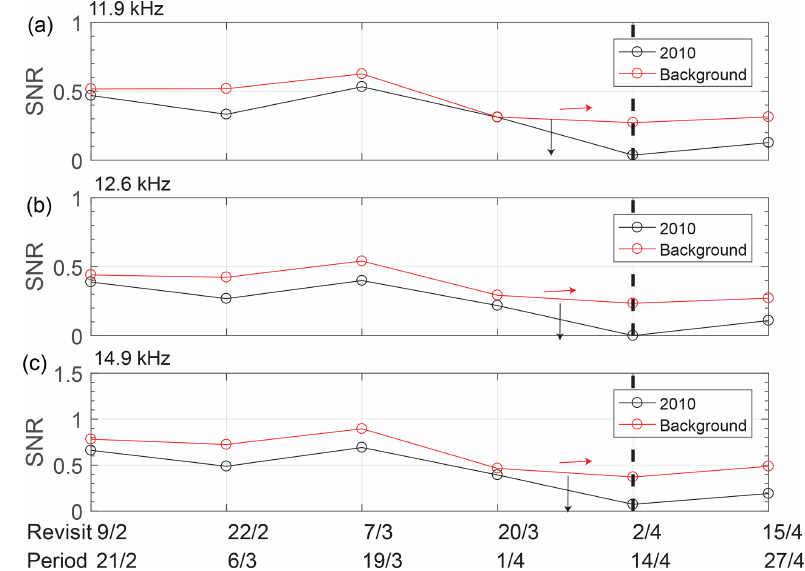
Figure 3. The average SNR variation with revisit periods inside the square region with the center of the epicenter. Panels (a–c) show SNR at 11.9, 12.6, and 14.9kHz and the numbers of the averaged data points. The green and red lines represent the SNR variations in 2010 and background time separately. The black dashed line represents the period with the end date of the main-shock